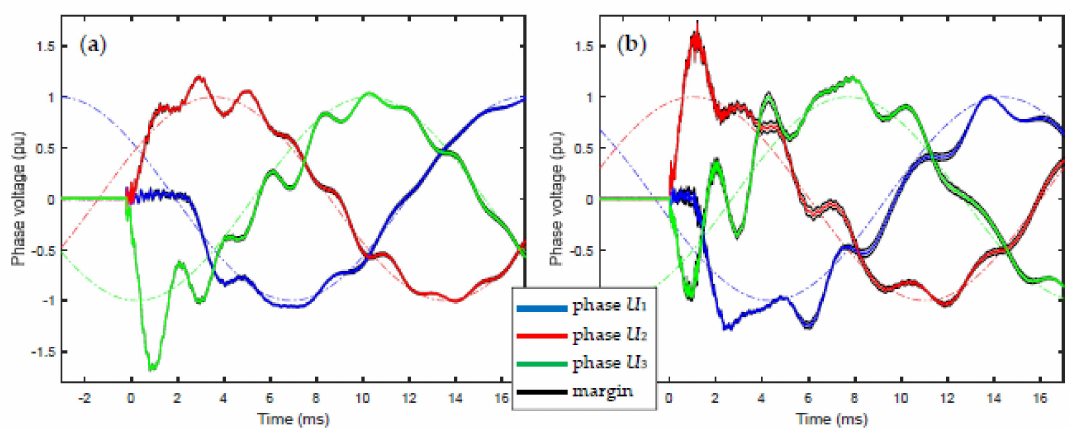
Figure 5. Part of the reconstructed waveforms (covering 10 cycles recorded with 5 Msample / s) around the switching moment for measurement at transition points. Coloured curves represent the phase voltages with one standard deviation confidence margins indicated in black: ( a ) Overvoltages from energization at the substation connected by 4.4 km overhead line to the transition point; ( b ) Overvoltages from energization at the substation connected via 6.8 km overhead line. Moments of contact can be observed from the extrapolated power frequency waveforms (dash-dotted